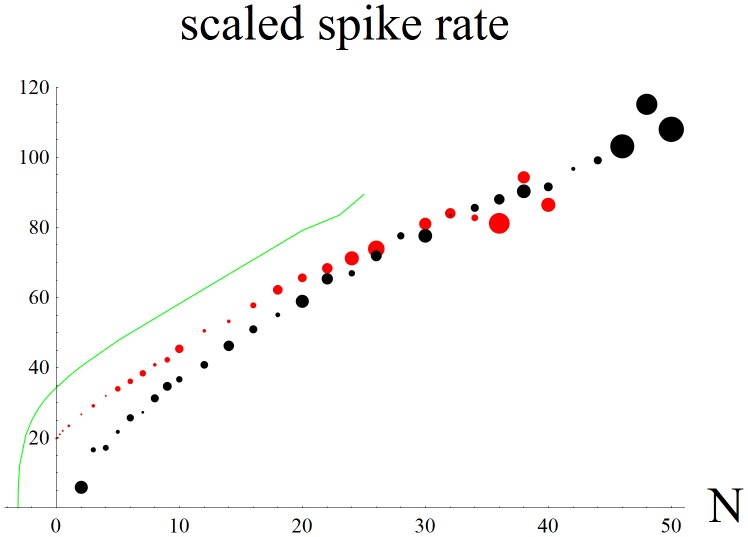
Spike rate vs. N, the average number of vesicles released by the IHC per sound wave cycle for the 3d SNIC model.The size of the data points shows the standard error in the spike rate, which increases with N (red; gKl = 8, gL = 5, gH = 1). The plot is similar to spike frequency vs. input current and is made linear across approximately a 48 dB range (from N∼1/8 to N∼32) by fast negative feedback from the low threshold potassium conductance gKl. For small input the small standard error allows the N  = 0, 1/8, 1/4 excitations to be resolved from each other, while for large inputs the accompanying large standard error limits the ability to resolve intensities above N = 32. Turning off inward leak H current moves dynamic range to higher sound intensities (black; gKl = 8, gL = 5, gH = 0; ∼27 dB range from N = 2 to 46). H was turned off as if it were under the control of cholinergic feedback from the olive. Here the standard error starts out large for the small spike rates just above the bifurcation (N = 2), decreases away from the bifurcation and then increases for large inputs. For comparison we show the loss of dynamic range and nonlinear rise of the spike rate due to turning off the low threshold potassium conductance (green; gKl = 0, gL = 5, gH = 1). This curve was extended to negative N to show the square root shape in the rise of the spike rate above the now 2d SNIC bifurcation. Fluctuations in the size of the standard errors occurred because spike rates and standard errors were calculated over short time intervals, trying to reproduce the approximately one quarter second that the auditory pathway has to resolve the intensities of specific formant frequencies in order to be able to identify a particular vowel sound in real time. At a given frequency that is sensed by a particular IHC small numbers of ANF rapidly and accurately determine the intensity of the tone, each using only a small number of spikes.